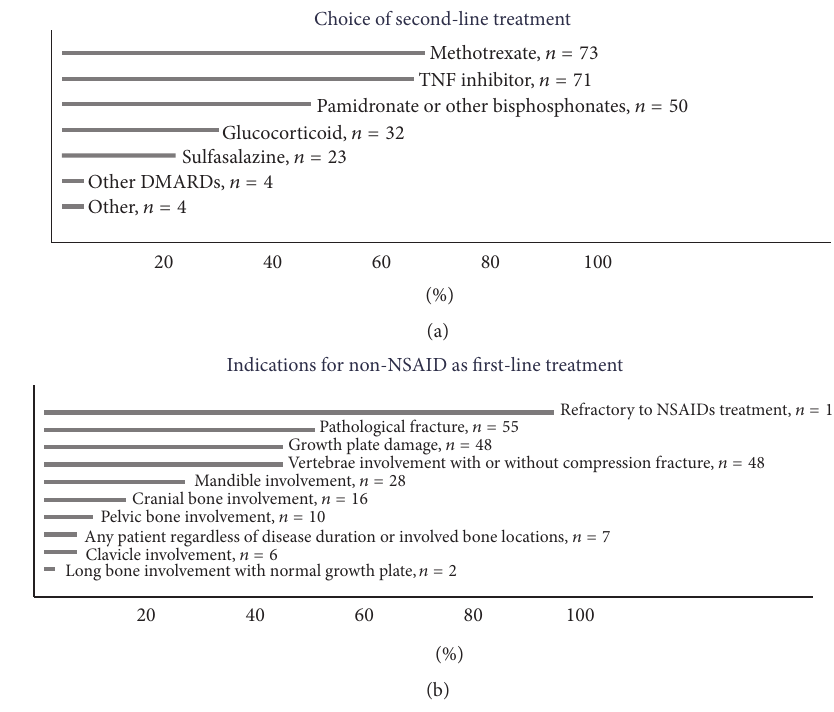
(28%), or the decision depended on initial severity and/or location of affected sites